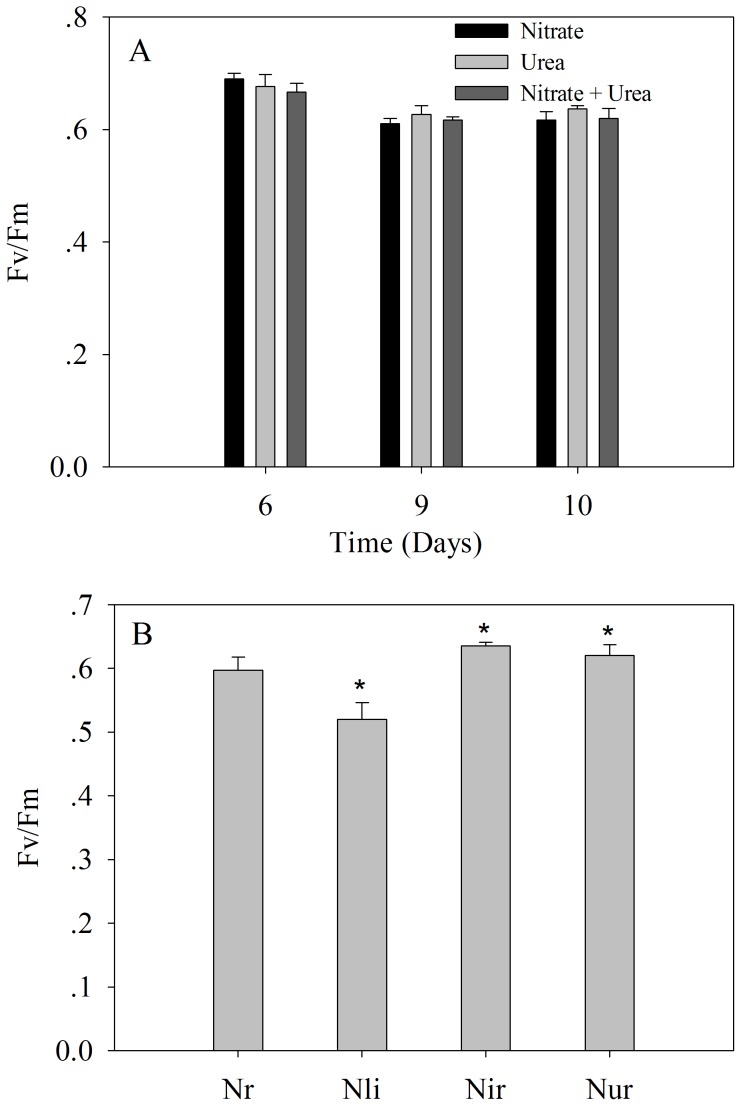
Photosystem II efficiency (Fv/Fm).A) A. anophagefferens cultures grown on urea, nitrate, and a mixture of urea and nitrate at the 6-, 9- and 10-day sampling points; B) A. anophagefferens cultures grown under nitrogen-replete (Nr), limited (Nli) and recovery conditions. Nir and Nur represent nitrate and urea addition, respectively. Nli was compared with Nr while Nir and Nur were compared with Nli. Significance values were expressed as follows: * P <0.05, ** P <0.001. Error bars represent standard deviation of the mean for the three biological replicates.